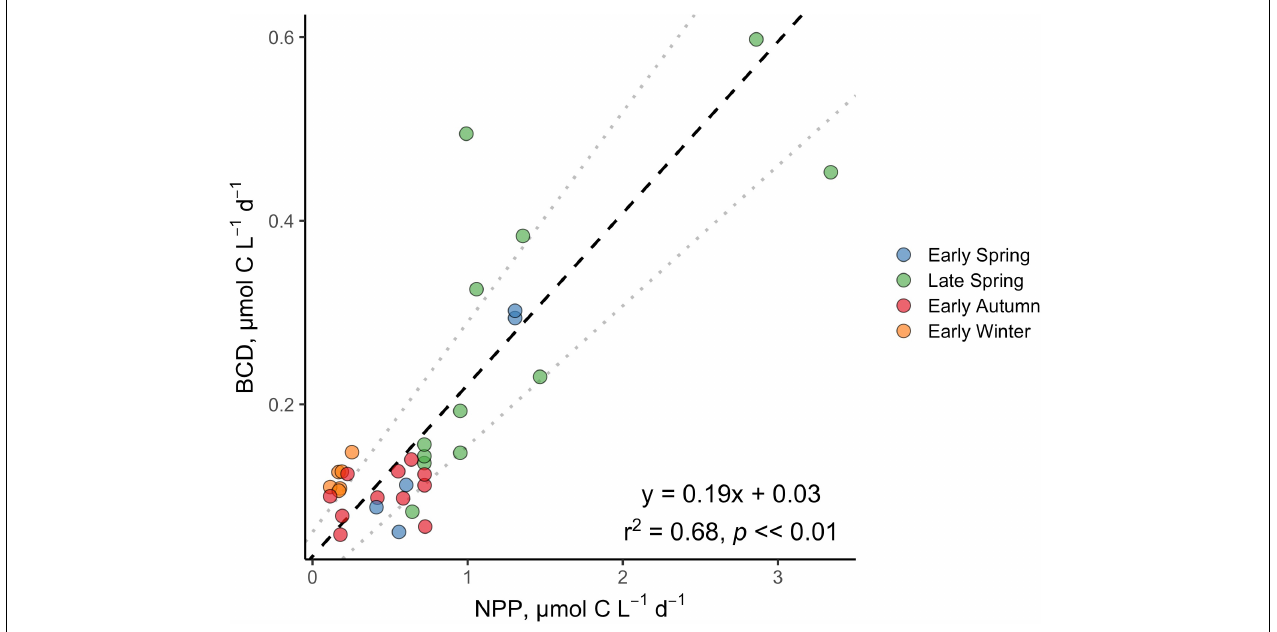
FIGURE 8 | Standardized (reduced) major axis model II linear regression between NPP and BCD. Dotted gray lines indicate the 2.5 and 97.5% confidence